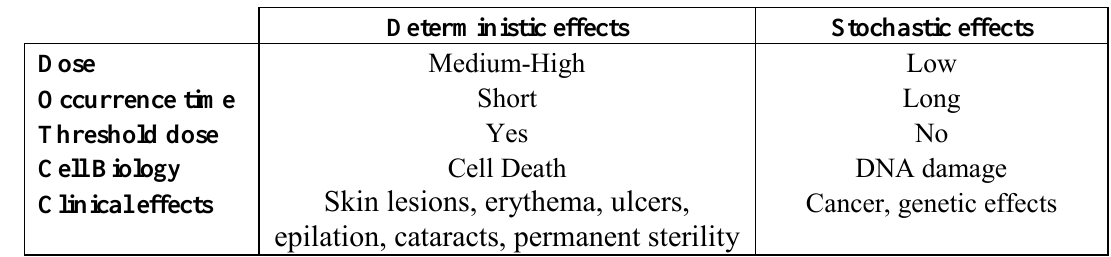
Table 1. Biological effects of ionizing radiation.